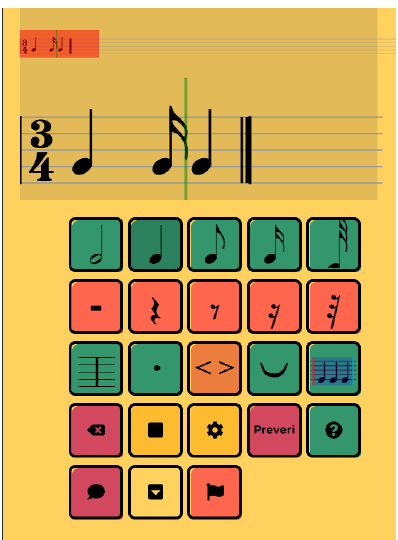
Figure 2. Rhythmic dictation